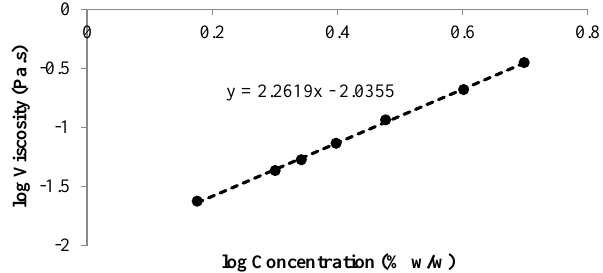
Figure 2. Log–log profiles of viscosity at 1000 s − 1 versus l-PEO concentration (% w / w ).